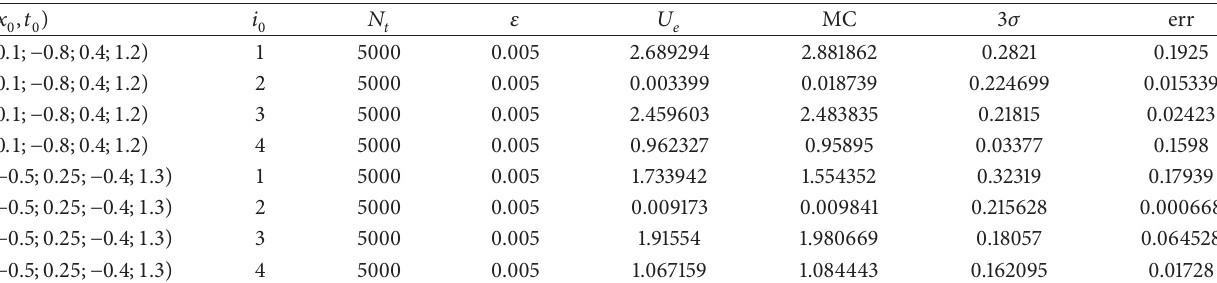
Table 1: The results of computational